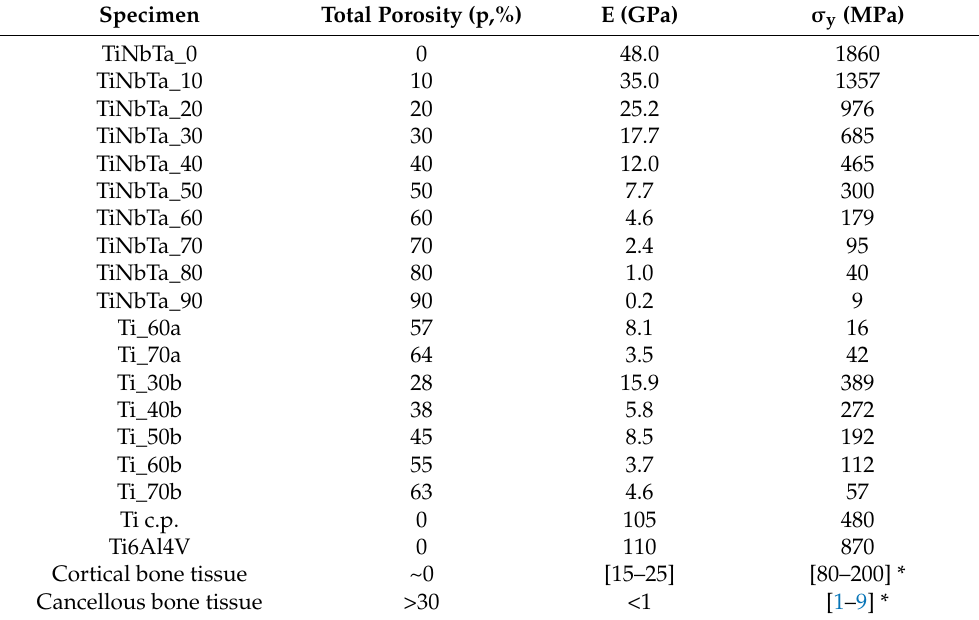
Table 1. Total volumetric porosity (p), elastic modulus (E), and yield strength ( σ y) for (a) the developed fully dense TiNbTa material and the corresponding TiNbTa foams, with volumetric porosities from 10 to 70 vol %, calculated by the Mondal equation [29]; (b) the Ti foams developed by the space-holder, also with volumetric porosities from 10 to 70 vol % and marked as “a” or “b” when NaCl or NH 4 HCO 3 was used as the space-holder, respectively; (c) commercial Ti c.p., commercial Ti6Al4V [4]; (d) cortical and cancellous bone tissues [5,31]. Specimen Total Porosity (p,%) E (GPa) σ y (MPa) TiNbTa_0 0 48.0 1860 TiNbTa_10